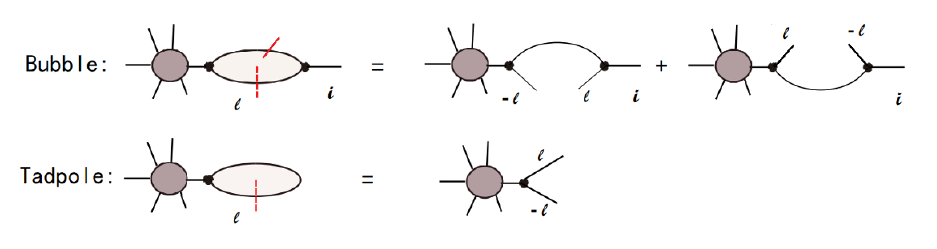
Figure 4 . The should-be-excluded one-loop Feynman diagrams of (cid:30) 3 theory and their correspond- ing tree diagrams after